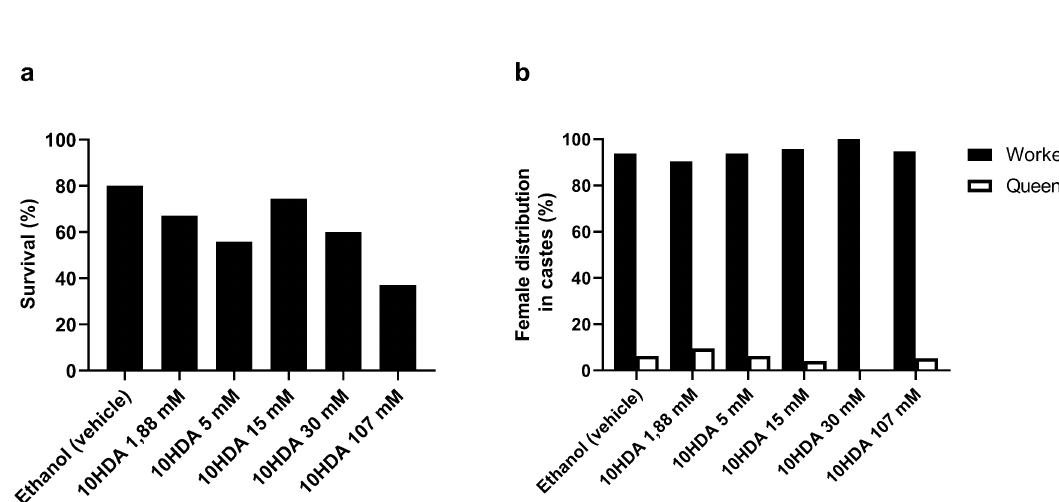
Figure 5. Effects of treatment of Melipona scutellaris on the third larval instar with 10HDA. Survival rate ( a ) and Distribution of females in castes, queen and worker ( b